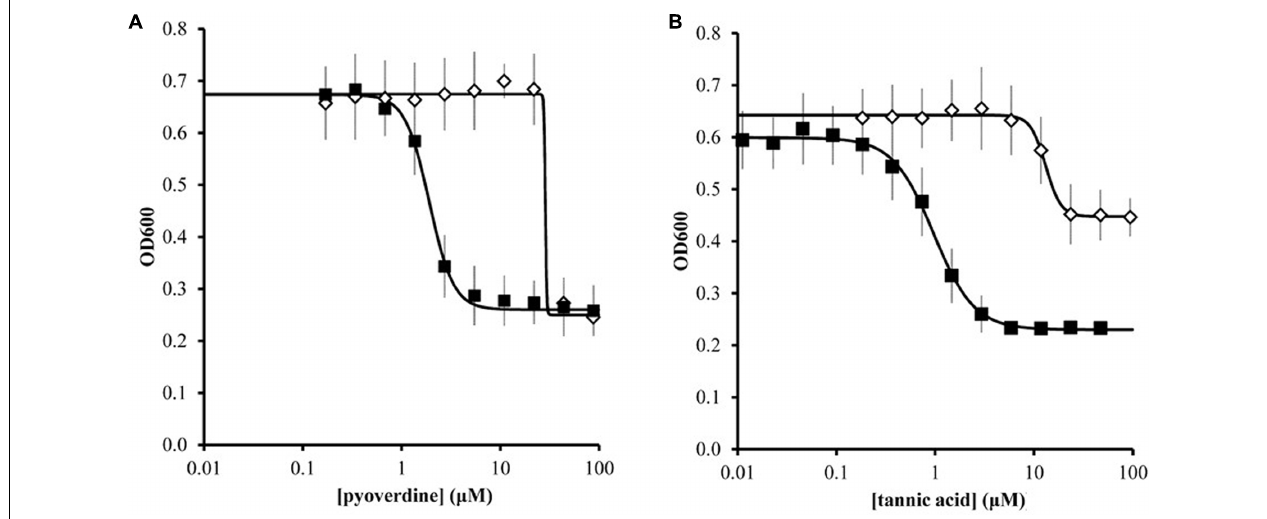
FIGURE 6 | Effect of pyoverdine (A) and tannic acid (B) on the growth of X. fragariae Fa P29 in liquid WBN medium. Shown are yield, i.e., OD 600 values measured 20 h after inoculation, as a function of chelating agent concentration. Each concentration was tested in the absence (filled squares) or presence (open diamonds) of supplemental 20 µ M FeSO 4 . Error bars indicate the standard deviation of measurements from three independent experiments. Solid lines represent the best fit curves to the data using the Hill equation. These curves were used to estimate IC 50 values. In the absence of pyoverdine (0 µ M) or tannic acid (0 µ M), the OD 600 values were 0.699 ± 0.042 and 0.599 ± 0.053, respectively. In the presence of 20 µ M FeSO4 but absence of pyoverdine or tannic acid, the OD 600 value were 0.676 ± 0.067 and 0.634 ± 0.061, respectively.